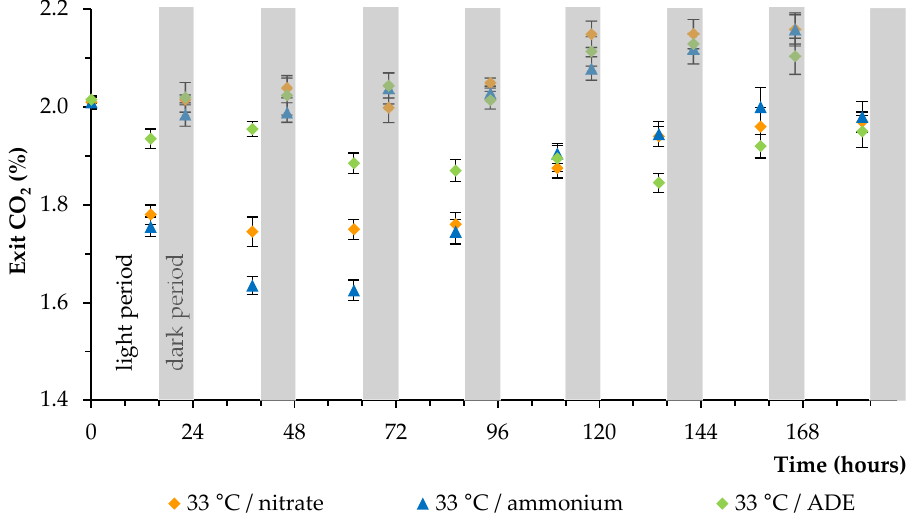
Figure 3. Changes in the level of carbon dioxide released from the photobioreactor under selected conditions (at 33 °C; measured with the Infors gas analyzer).